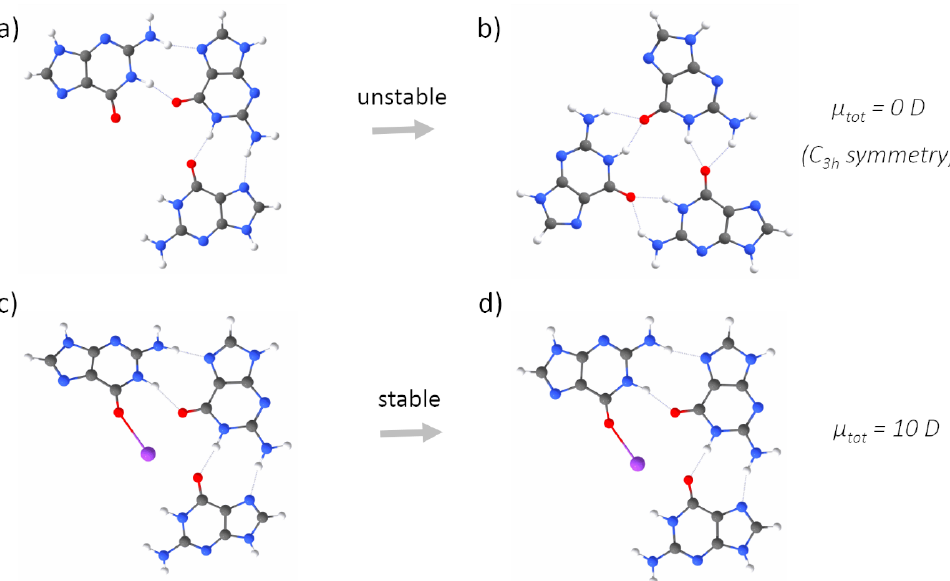
Figure 6. The optimizations of three adjacent guanines without ( a → b ) and with ( c → d ) a metal (here, potassium) cation, calculated at the QM level of theory. The optimization without a cation leads to the cancellation of the dipole moments by a reorganization of the guanines, leading to a triangular orientation stabilized by Hoogsteen-like hydrogen bonds. The presence of the cation stabilized the mutual orientation of guanines characteristic of a G-tetrad, via the Hoogsteen fingerprint of hydrogen bonds, despite a non-zero total dipole moment of the system.